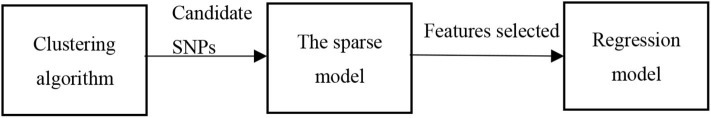
A three-stage frame diagram.